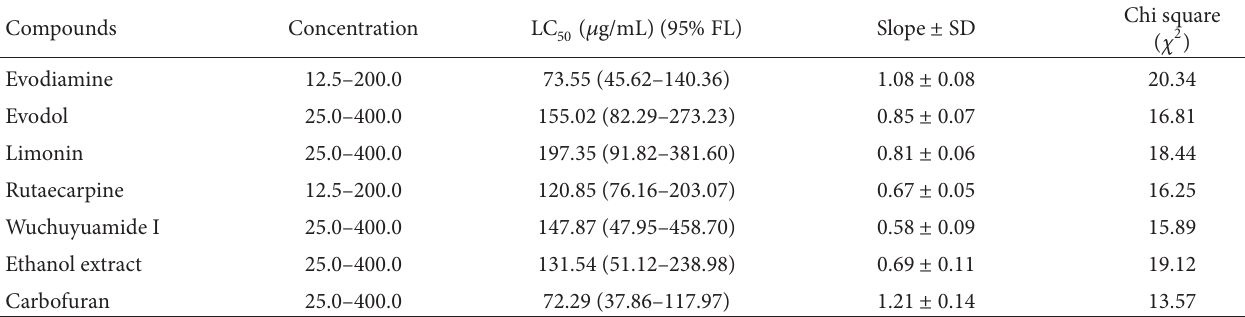
T 1: Nematocidal toxicity of the ethanol extract of E. rutaecarpa and isolated compounds against Meloidogyne incognita .